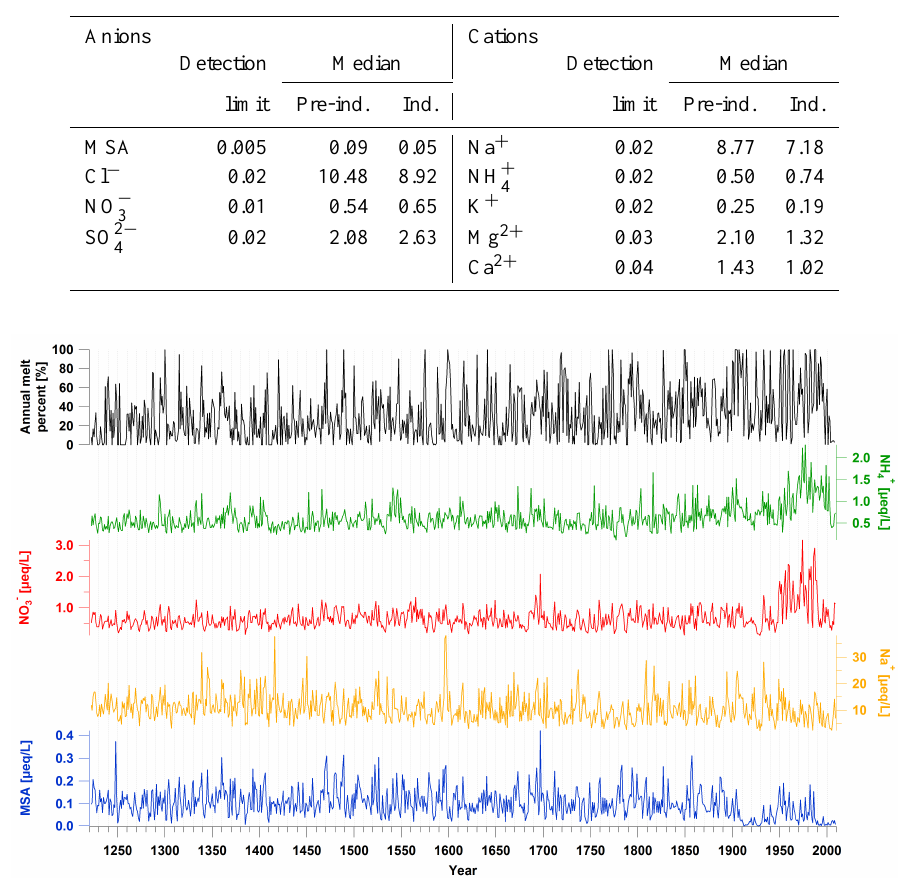
Figure 3. Temporal records of annual average concentrations of MSA, Na + , NO −